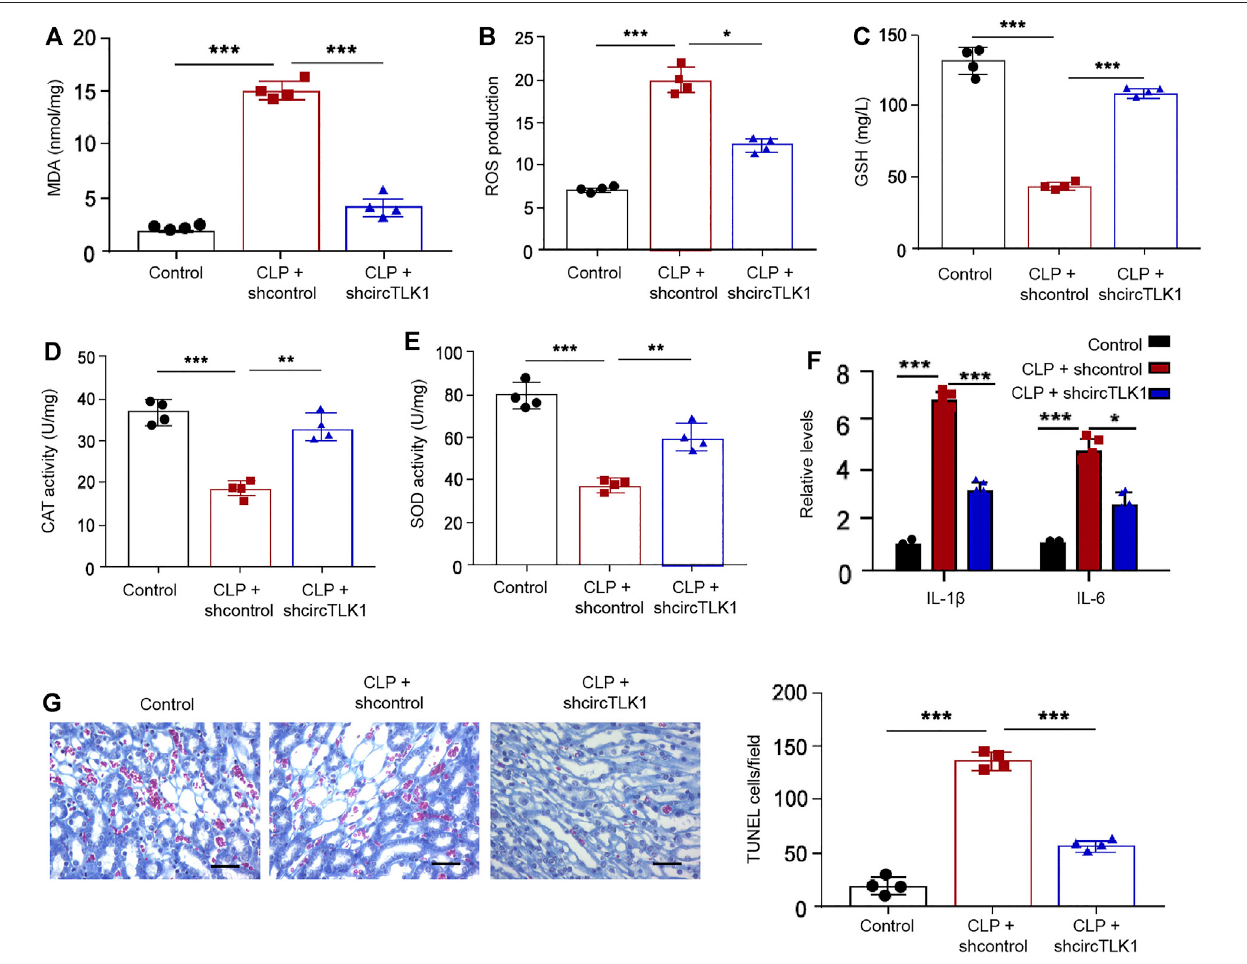
FIGURE 2 | Depletion of circTLK1 decreases oxidation stress, in fl ammation, and apoptosis in the sepsis-related AKI rat model. (A – G) The CLP-induced sepsis- related AKI rat model was established in Wistar rats ( N (cid:2) 4), followed by the treatment of circTLK1 shRNA. The cecum was exposed without perforation in the sham groups. (A) MDA levels in the rats. (B) ROSproduction in therats. (C) GSH levels in therats. (D) CAT activities inthe rats. (E) SOD activitiesin the rats. (F) IL-1 β and IL-6 release in the rats. (G) TUNEL assays of apoptosis analysis in the rats, bar (cid:2) 50 μ m. The experiments were replicated at least three times, mean ± SD, * P < 0.05, ** P < 0.01, *** P <